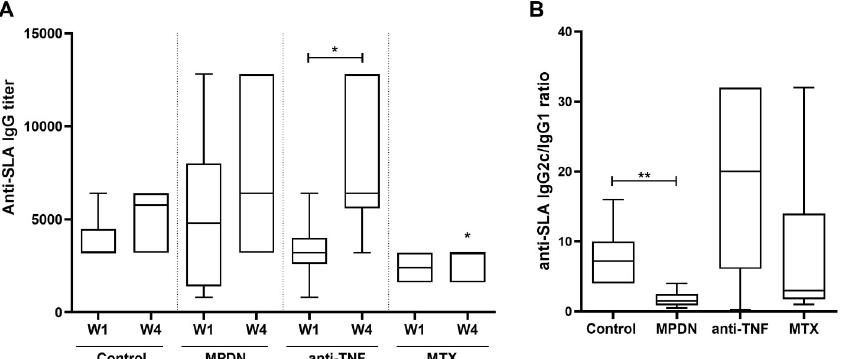
Fig 3. Humoral response of immunosuppressant-treated mice infected with L . infantum to soluble Leishmania antigen. C57BL/6 mice (6 animals per group) were treated with PBS (control), MPDN (methylprednisolone), anti- TNF antibodies or MTX (methotrexate) one week before infection with 1x10 7 L . infantum promastigotes. Samples of sera of each animal were collected one (W1) and four (W4) weeks after infection to determine anti-SLA antibody titers by ELISA using limiting dilutions. The results are shown as median and whisker (min to max) plots for (A) anti-SLA total IgG antibodies one and four weeks after infection and (B) anti-SLA IgG2c/IgG1 subclasses ratio at W4. � p < 0.05 �� p <